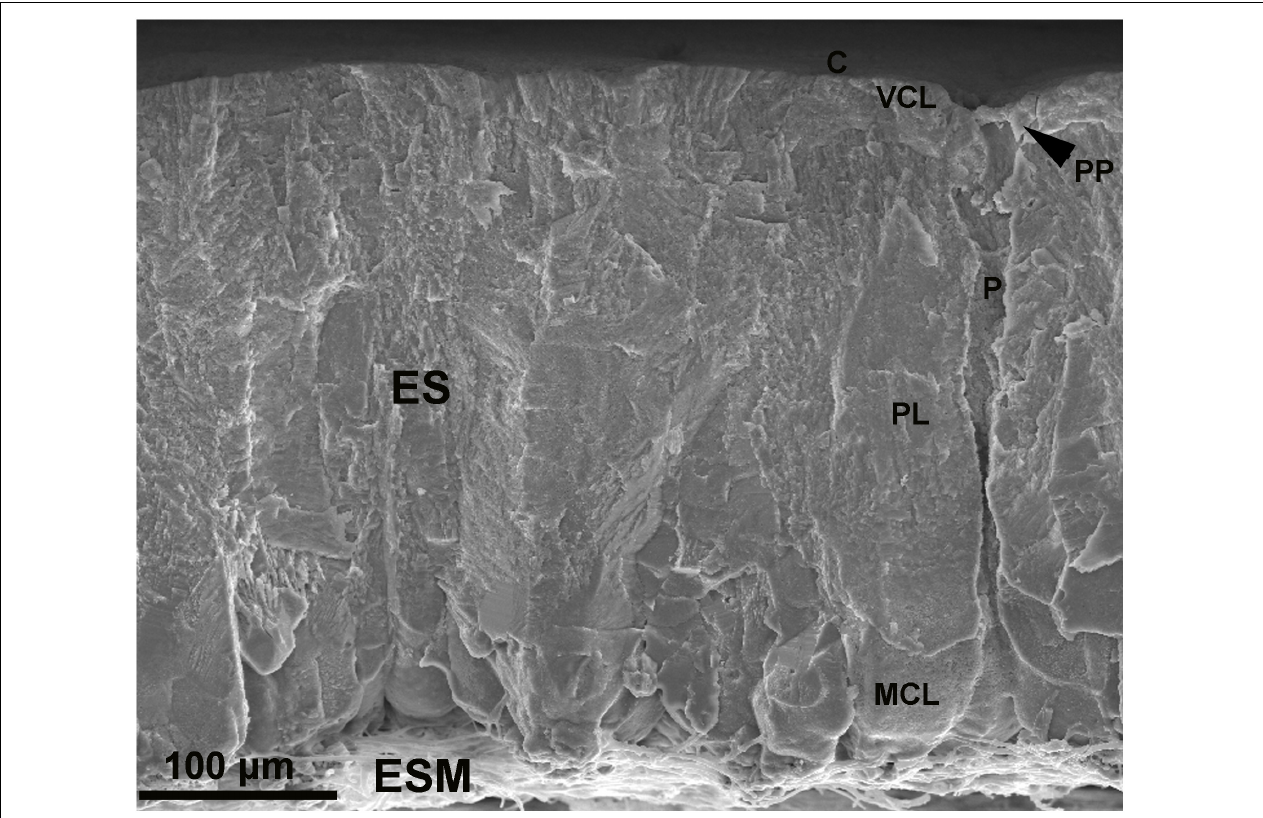
FIGURE 1 | Morphology of the eggshell and eggshell membranes revealed by scanning electron microscopy (SEM). Cross-fractured eggshell reveals the calcified eggshell (ES), constituted of cuticle (C), vertical crystal layer (VCL), palisade layer (PL), and mammillary cone layer (MCL); with the associated eggshell membranes (ESM). Respiratory pore (P); pore plug (PP). (Nano Imaging Facility, Carleton University, Ottawa,